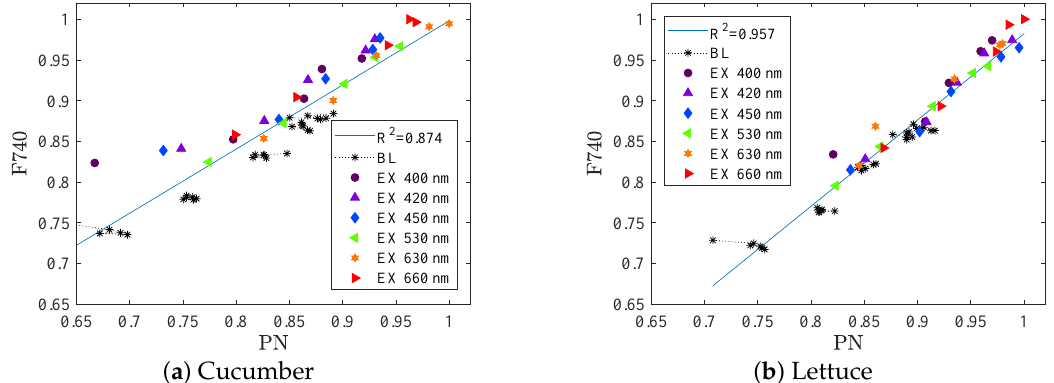
Figure 5. Normalized fluorescence at 740nm versus normalized photosynthetic rate. The black stars correspond to measurements at background light, i.e., intensity 160 µmolm − 2 s − 1 and the five clusters corresponds to five different spectral distribution from 50% up to 100% red light. The coloured dots correspond to measurements with additional excitation light with one LED at a